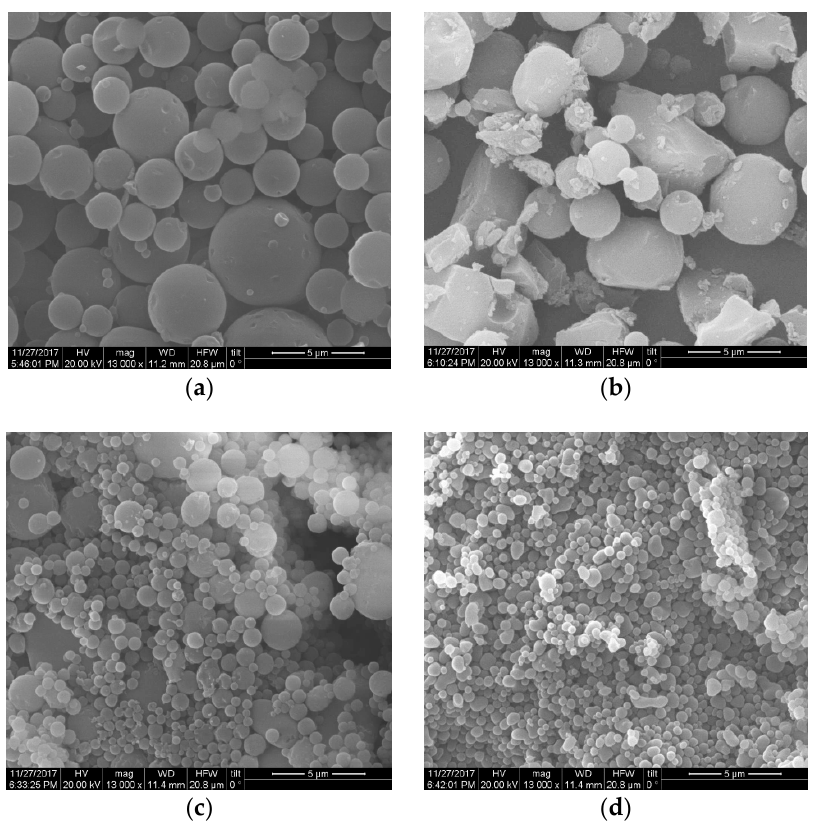
Figure 4. Morphology of lignin isolated with HOS-SE pretreatment with 60% v/v ethanol content ( a ) and after homogenization at 500 bar in ethanol/water solution with ethanol content of ( b ) 0% v/v ; ( c ) 50% v/v ; and ( d ) 75% v/v .